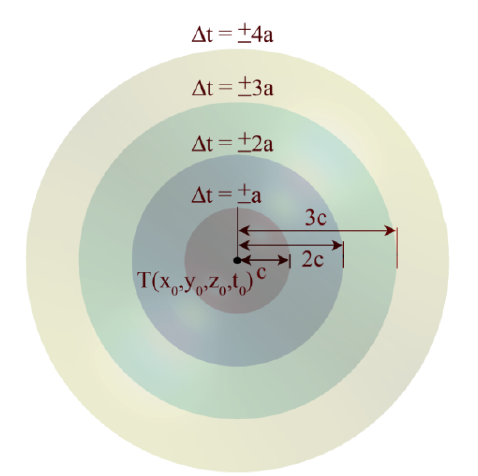
Figure 2. A general right spherical double hypercone in 4-dimensional space mapped to 3-dimensional space at five different points in